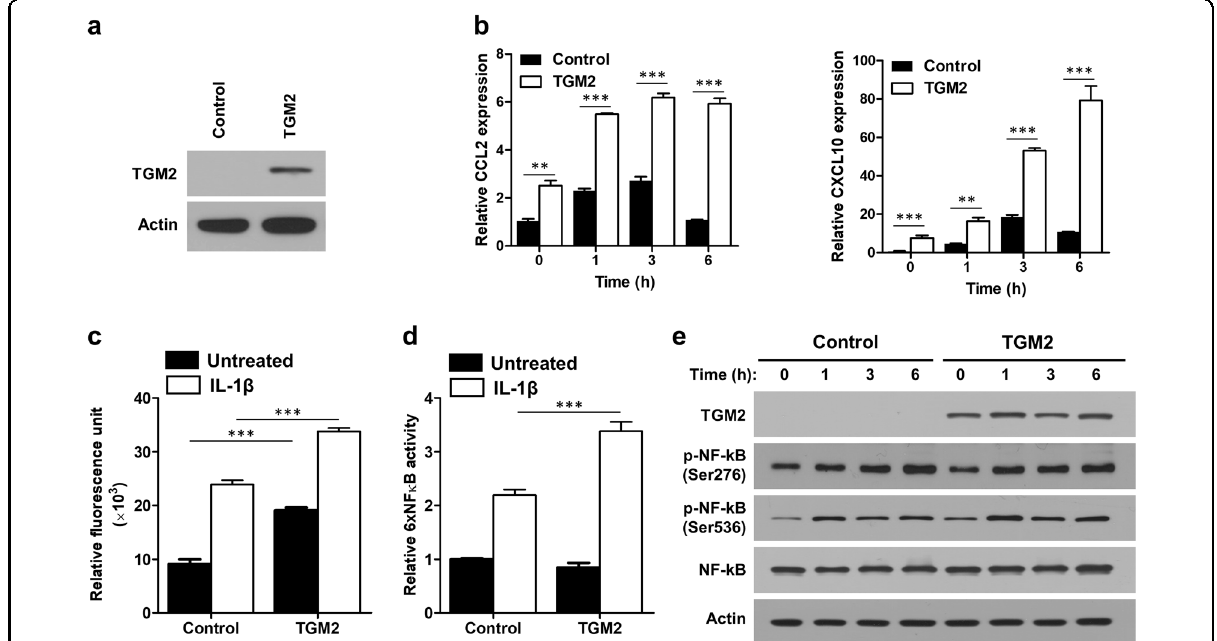
Fig. 5 Regulation of interleukin-1 β (IL-1 β )-induced chemokine expression in gastric cancer cells by TGM2. a Overexpression of TGM2 in MKN- 45 cells. The protein expression levels of TGM2 were evaluated by western blotting. b mRNA levels of CCL2 and CXCL10 in IL-1 β (10 ng/mL)-treated MKN-45 cells. The mRNA expression of CCL2 and CXCL10 in TGM2-overexpressing and control cells was measured by real-time PCR at the indicated times. Asterisks indicate statistically signi fi cant differences (** P < 0.01; *** P < 0.001) compared to the control cells. c THP-1 macrophage migration induced by conditioned medium from MKN-45 cells. TGM2-overexpressing and control MKN-45 cells were treated with IL-1 β (10 ng/mL), and the chemotactic effect of conditioned medium on THP-1 cells was estimated with a cell migration assay. Migrated cells were lysed and quanti fi ed using a fl uorescent dye. Asterisks indicate statistically signi fi cant differences (*** P < 0.001) compared to control cells. d The activity of an NF- κ B-responsive element (6 × NF κ B) after IL-1 β treatment (10 ng/mL). The activity of the NF- κ B-responsive element was estimated using a luciferase reporter assay to assess TGM2-overexpressing and control MKN-45 cells. Asterisks indicate statistically signi fi cant differences (*** P < 0.001) compared to control cells. e Time-dependent changes in the protein levels of NF- κ B after IL-1 β treatment (10 ng/mL). The protein levels of total and phospho-NF- κ B (Ser276 and Ser536) in TGM2-overexpressing and control MKN-45 cells were evaluated by western blotting at the indicated